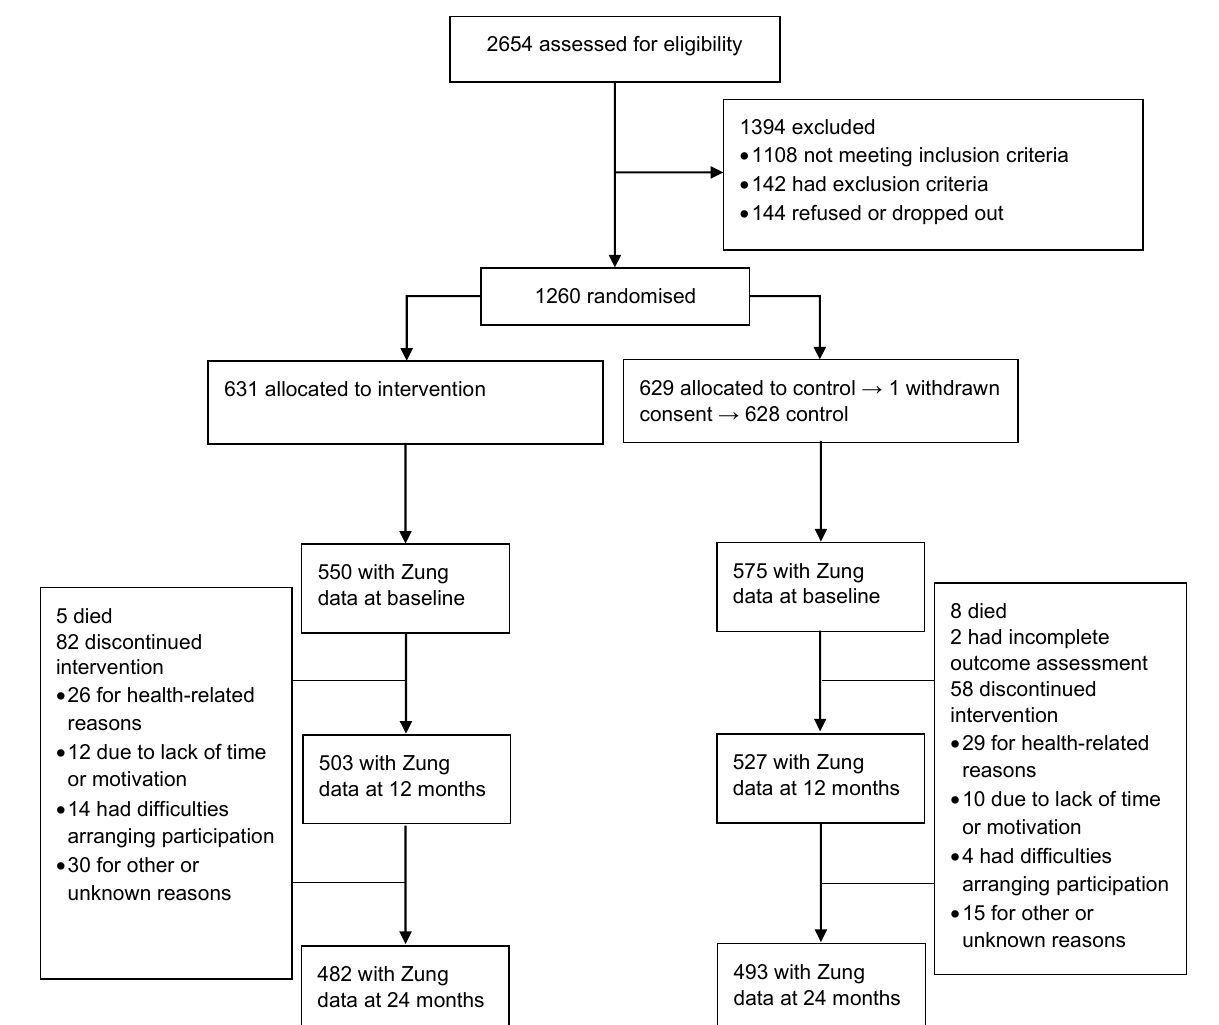
Figure 1. CONSORT flow chart of the study design.